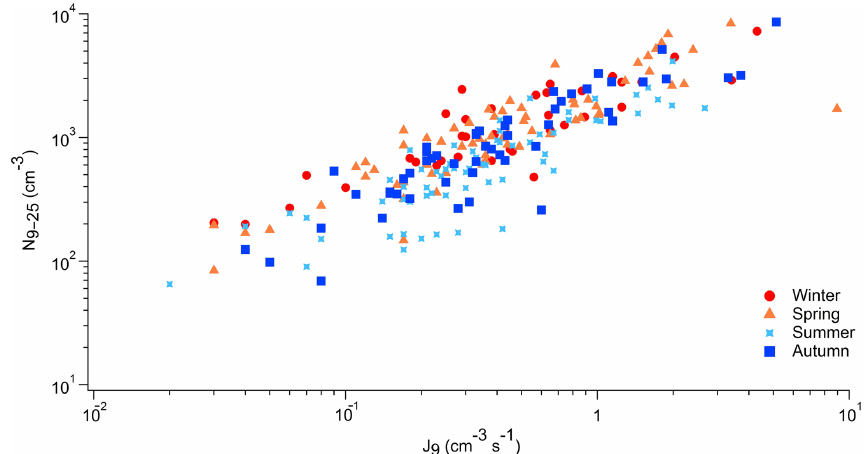
Figure 7. Scatterplot of the number concentration of nucleation mode particles ( N 9–25 ) (hourly maximum value during the event) versus formation rates of 9nm particles ( J 9 ) at Finokalia, for events when J 9 could be calculated with a good level of confidence (Class I events).